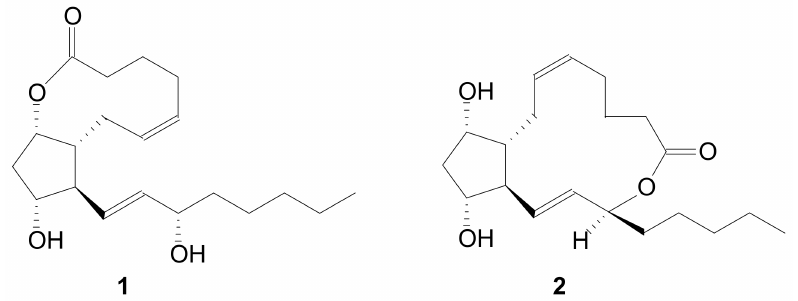
Figure 1. The first synthesized prostaglandin lactones, PGF 2 α -1,9- and PGF 2 α -1,15-lactones.